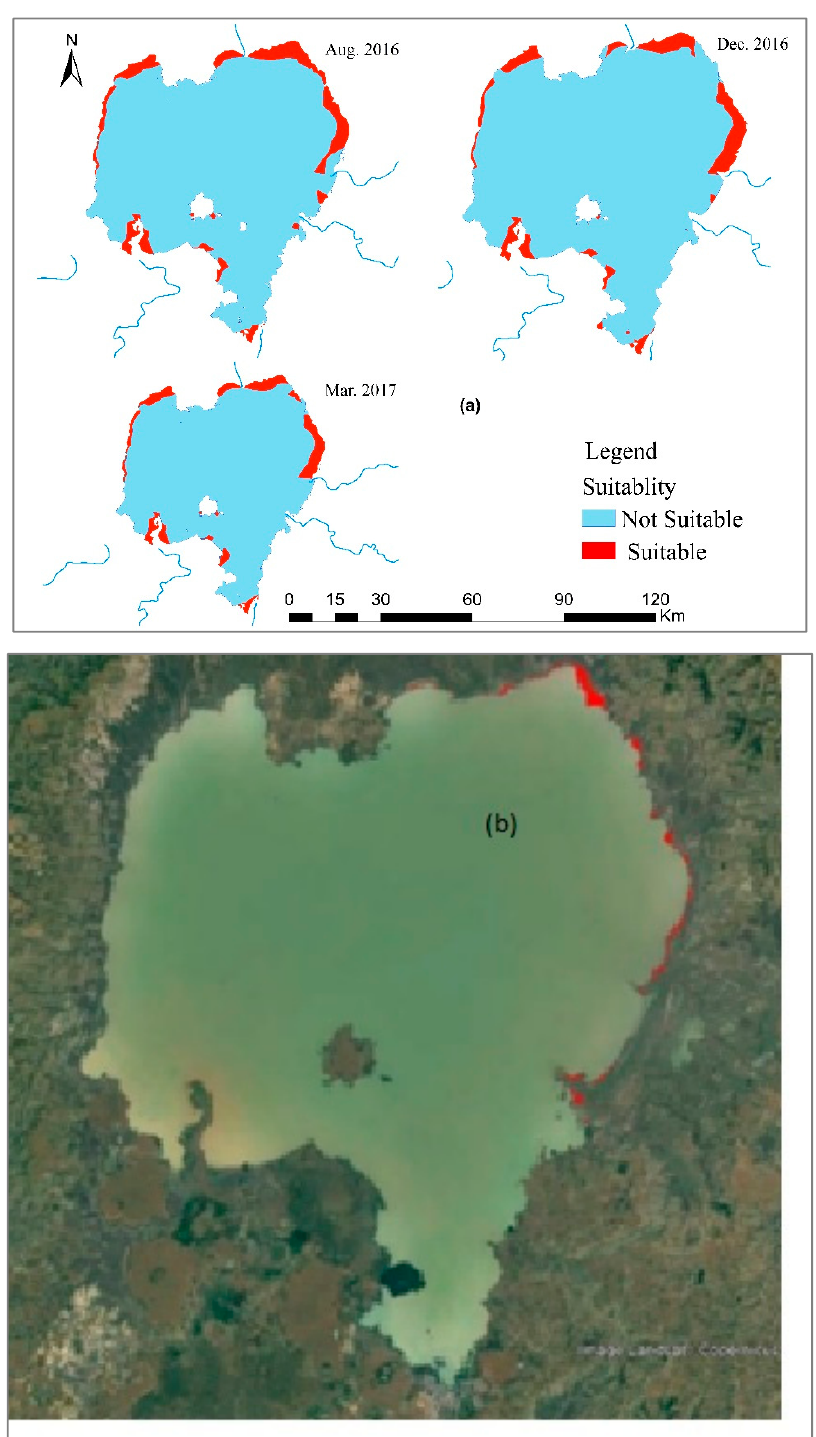
Figure 6. Predicted suitable area using multi criteria analysis for water hyacinth growth in different months ( a ). Map of Lake Tana and its invaded area by water hyacinth (red color) from 6–10 October 2018 (prepared by GPS tracking and overlaying on Google Earth) ( b ).